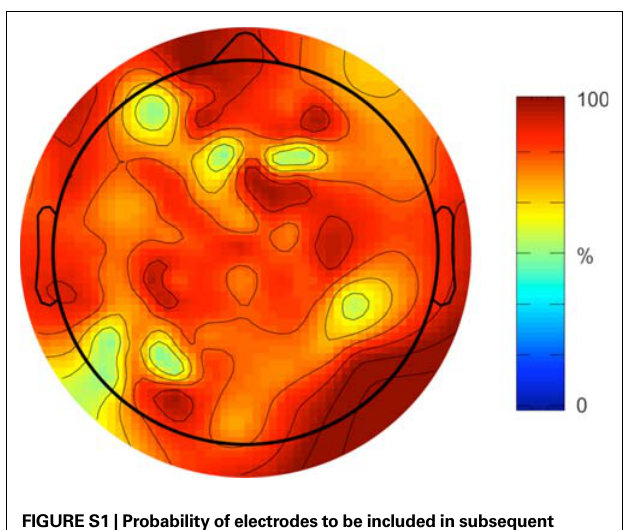
FIGURE S1 | Probability of electrodes to be included in subsequent analyses as a function of electrode location. Warm (red) colors indicate increasing